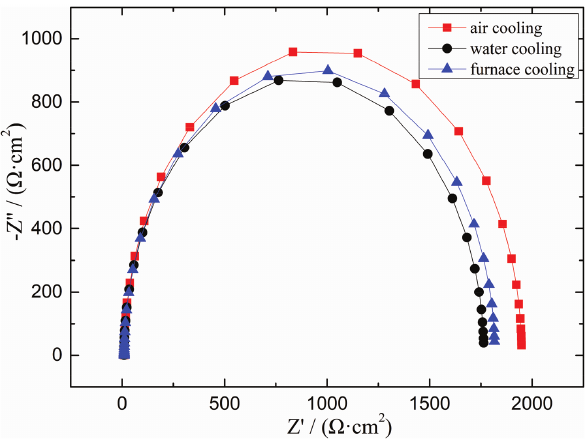
Figure 2: AC impedance spectroscopy of the